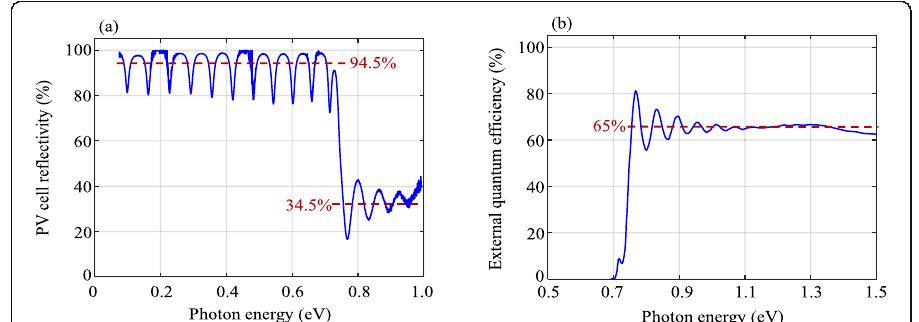
Fig. 3 Reflectivity and external quantum efficiency of one of the thermophotovoltaic cells. For this cell, sub- bandgap reflectivity is 94.5%. The above-bandgap reflectivity is the 34.5% Fresnel reflectivity at the air- semiconductor interface. The cell converts 65% of the above-bandgap incident photons to electron-hole pairs, as given by the external quantum efficiency on the